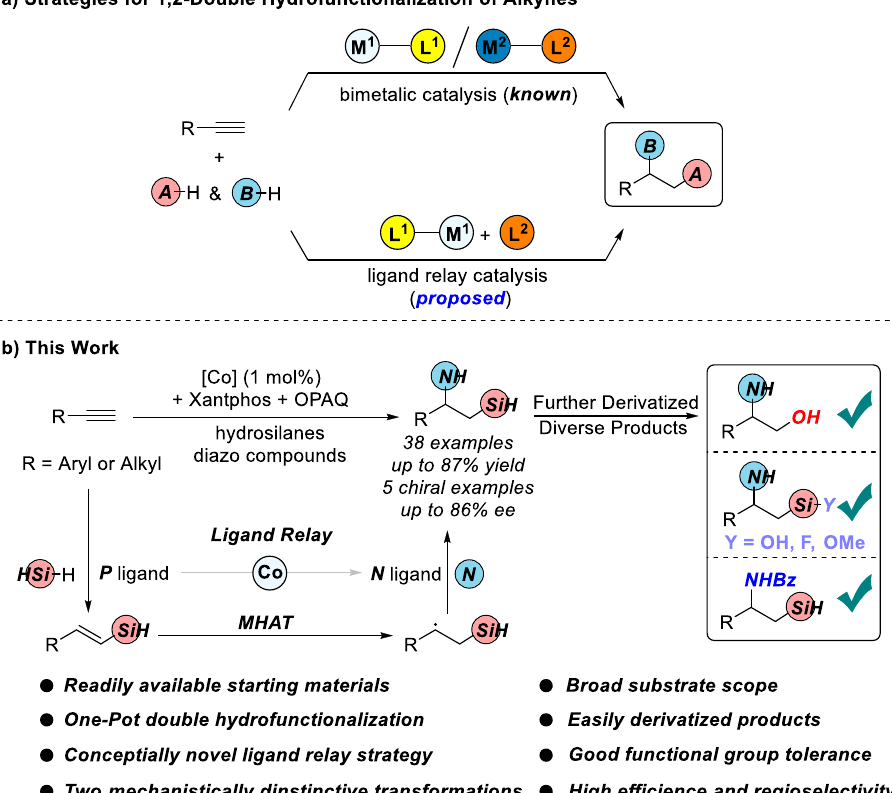
Fig. 2 Sequential strategies for double hydrofunctionalization of alkynes to construct 1,2- N,Si Compounds. a Strategies for 1,2-double hydrofunctionalization of alkynes. b Cobalt-catalyzed sequential hydrosilylation/hydrohydrazidation of terminal alkynes via ligand relay